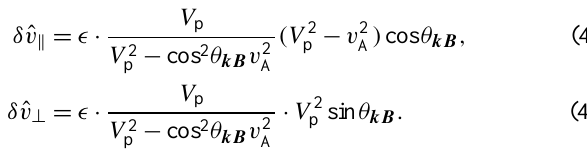
Figure 2. Theoretically predicted features of MHD waves. (a) Mag- nitudes of wave phase speed along z direction θ kB . (b) Compression due to fast and slow waves versus different θ kB , with vertical axis representing δ ˆ ρ/δ ˆ v (cid:107) for slow mode (red), and δ ˆ ρ/δ ˆ v ⊥ for fast mode (blue). Both horizontal axes represent θ kB in degrees. Data are computed with v A = 2, c s = 1, and ρ 0 = 1.